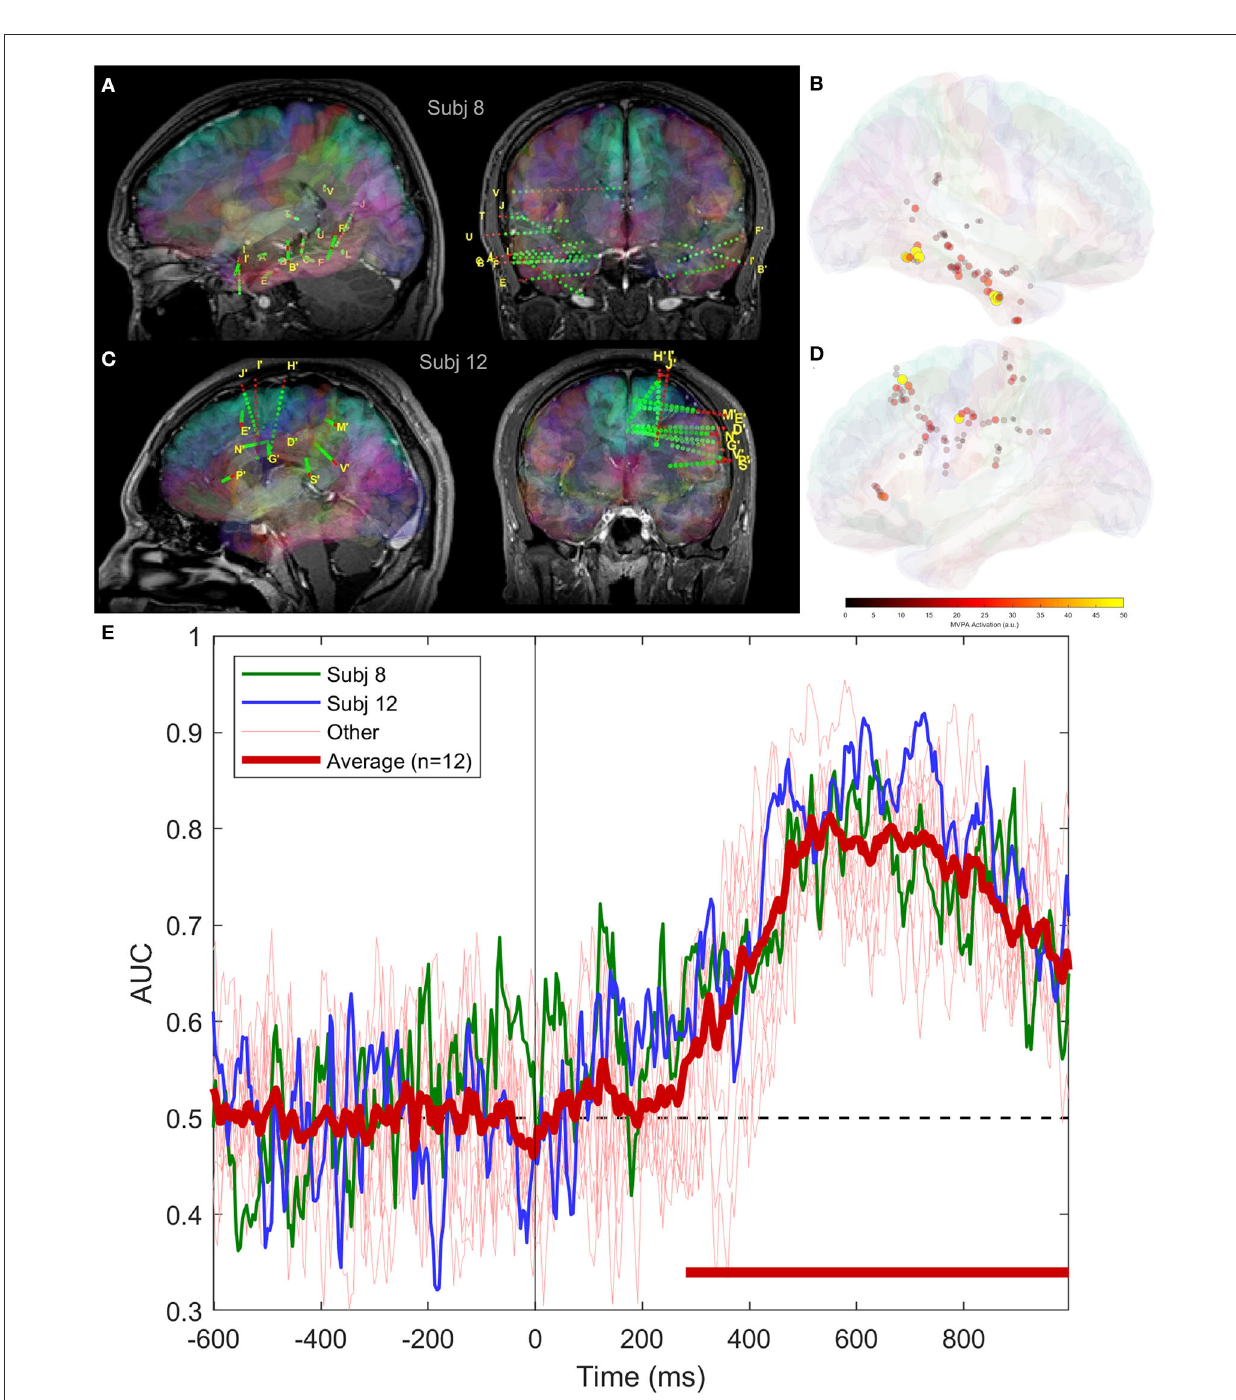
FIGURE5 Classifier performance using intracranial signals for two patients having SEEG implantation covering different areas of the brain; (A) bilateral implantation in subject 8, covering temporal lobe, including mesial structures; (B) mean magnitude of activation patterns in subject 8 across the entire trial duration; (C) electrode locations in subject 12, frontal, parietal and cingulate areas; (D) same as (B) , but for subject 12; and (E) average and individual classifier